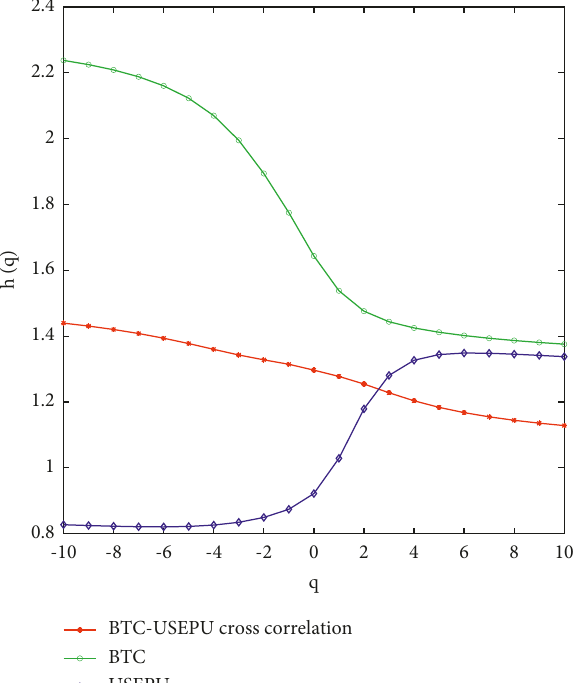
Figure 5: Generalized Hurst exponent of h ( q ) versus q for BTC and USEPU cross-correlation, the correlation within BTC, and the correlation within